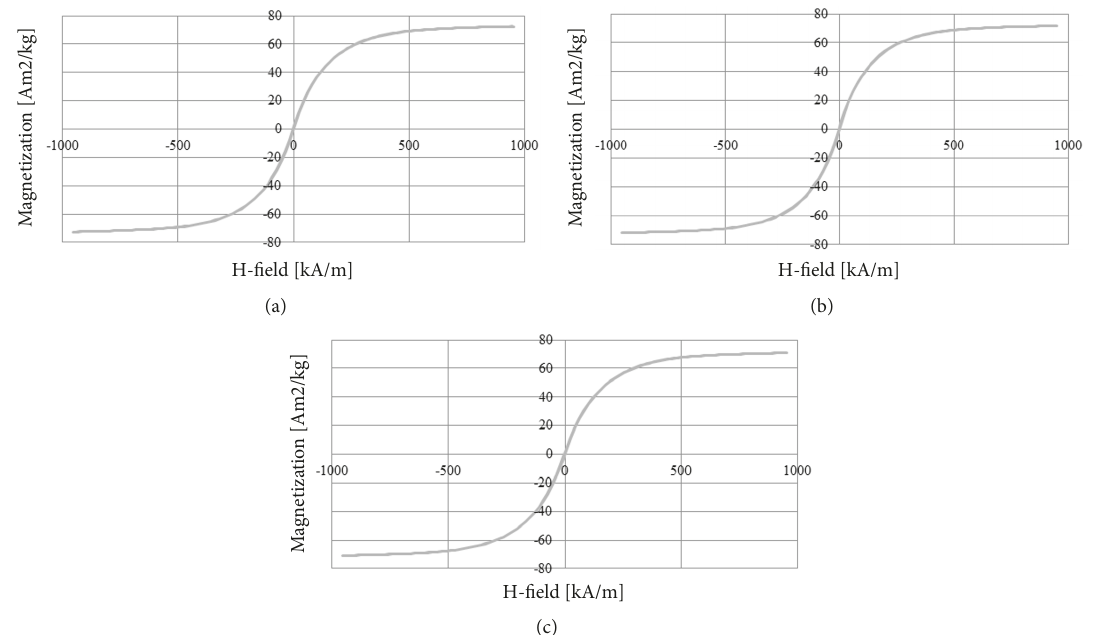
than twice compared to the vulcanizates obtained by com- monly used methods (mixing and rolling).